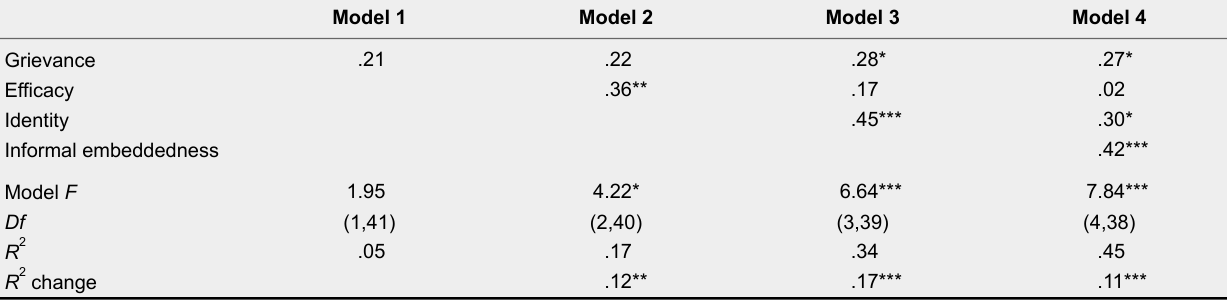
Hierarchical regression of protest participation on grievances, collective efficacy, identification and informal